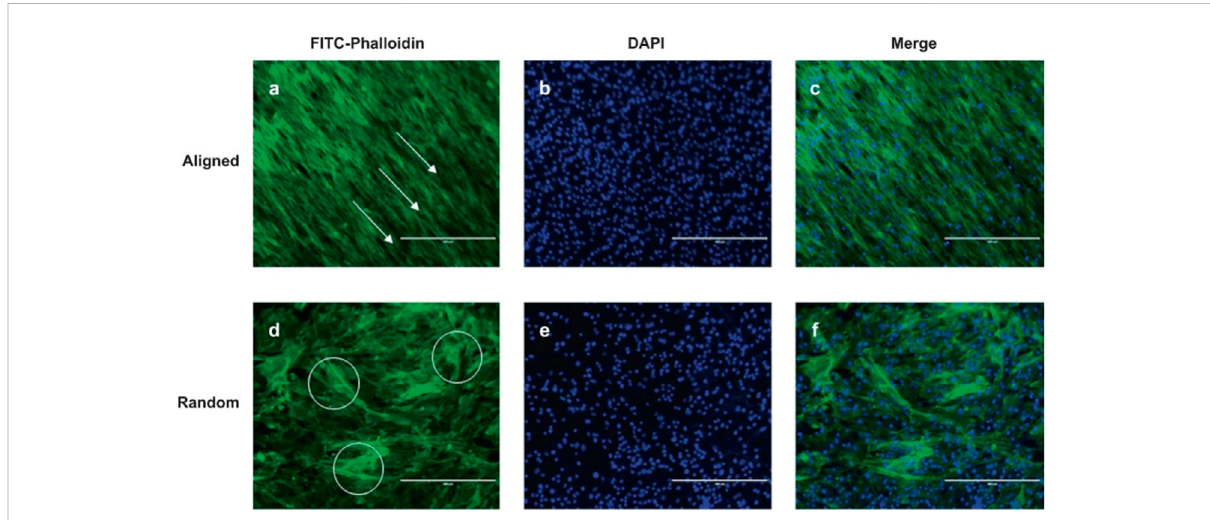
FIGURE 5 AF stem cell cytoskeletal images of aligned (A – C) and random (D – F) scaffolds were processed using FITC-phalloidin (green) and DAPI (blue) staining. White arrow and circle are the selected represent area. Scale bar = 400 μ m. DAPI (4 ′ ,6-diamidino-2-phenylindole). Reproduced with permission from (Liu et al.,